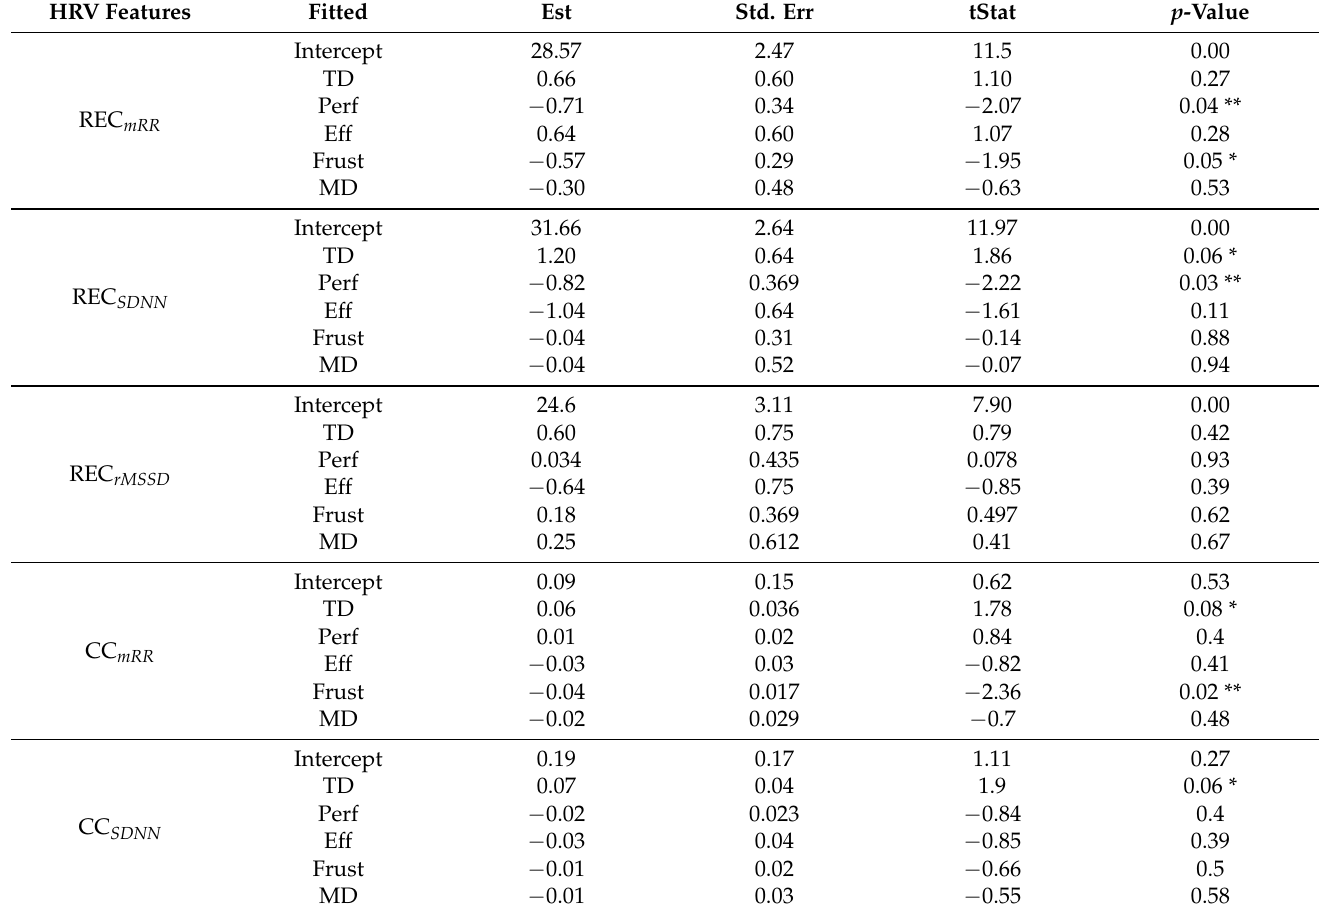
Table 3. Multiple linear regression model of MdRQA and NASA-TLX scores. Column head- ers, from left: fitted NASA-TLX scores; model estimate; standard error of the model; t statistics; p significant